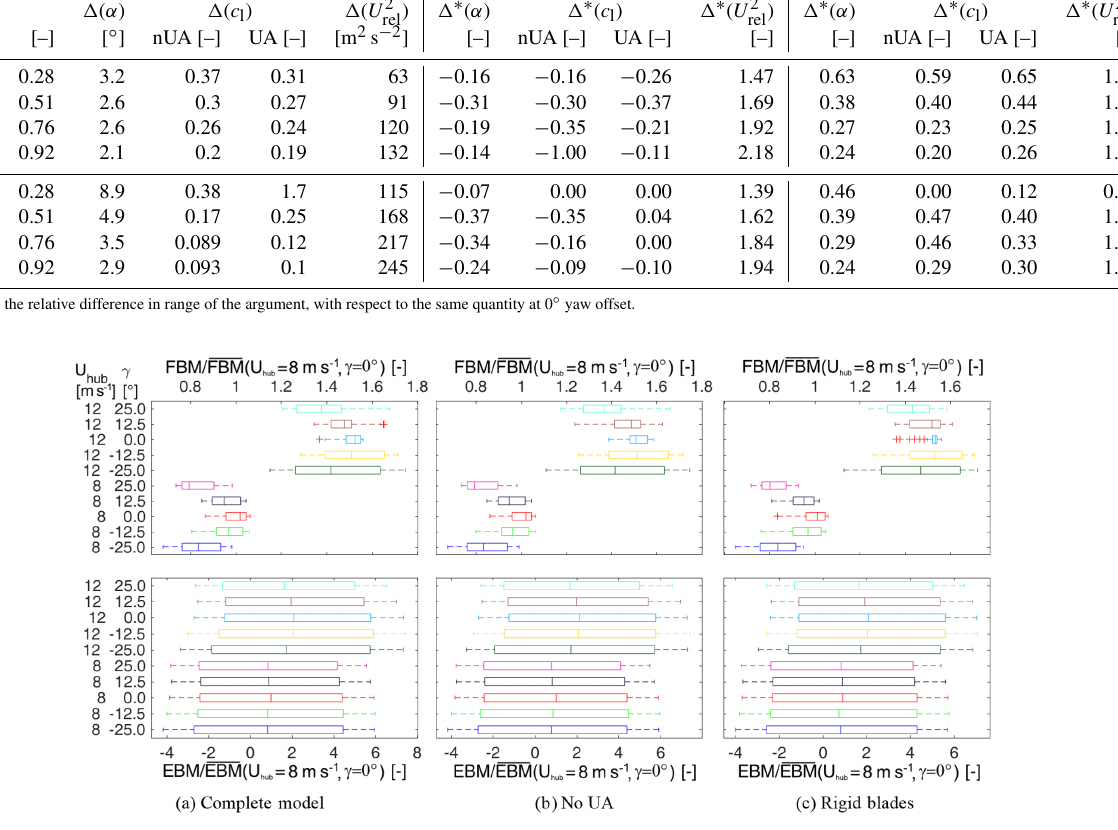
Figure 6. (a) Nondimensional FBM (top) and EBM (bottom) boxplot statistics for the various cases of U hub (8 and 12ms − 1 ) and γ ( − 25 to 25 ◦ ) as indicated along the y axis, as calculated by FASTv8 for a complete model of the GEWT. The loads are normalized by the respective means at 8ms − 1 and 0 ◦ yaw offset. (b) As in (a) but calculated excluding UA effects, and (c) as in (a) but calculated with rigid blades and